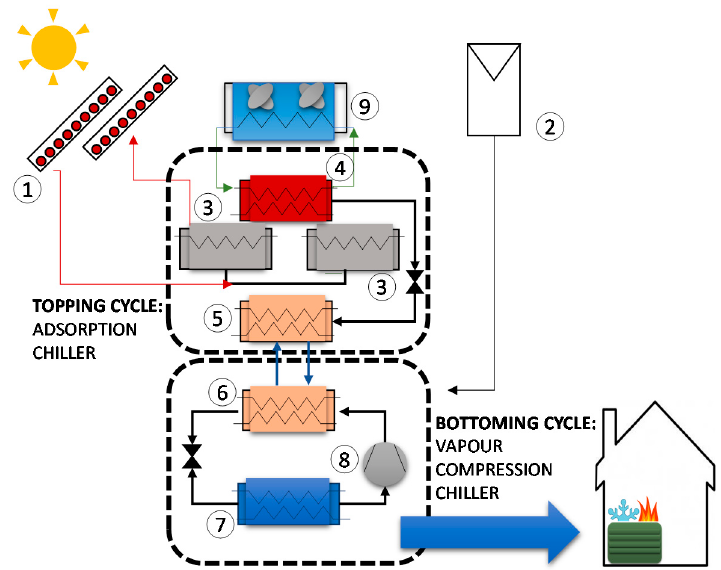
Figure 1. The hybrid system proposed: 1) solar thermal collectors field. 2) photovoltaic panels. 3) adsorbers of the adsorption chiller. 4) adsorption chiller condenser. 5) adsorption chiller evaporator. 6) vapour compression chiller condenser. 7) vapour compression chiller evaporator. 8) compressor.